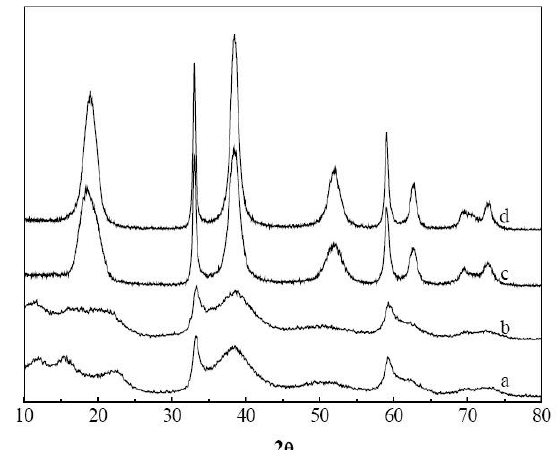
Figure 1. XRD patterns of Ni(OH) obtained at different conditions: 2 (a) NaOH solution only; (b) NaOH solution+ SDBS (1.1×10 -4 mol); (c) NaOH solution+EN (4 mL); (d) NaOH solution+ SDBS (1.0×10 -5 mol) + EN (2 mL).